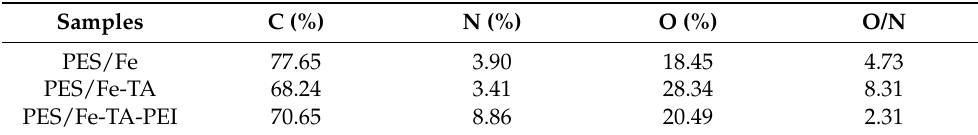
Figure 2. ( a ) ATR-FTIR spectra; ( b ) XPS spectra of the PES/Fe, PES/Fe-TA, and PES/Fe-TA-PEI membranes; High-resolution XPS spectra of N 1s ( c ) PES/Fe-TA membrane and ( d ) PES/Fe-TA-PEI membrane. Table 1. The element content of various membranes.